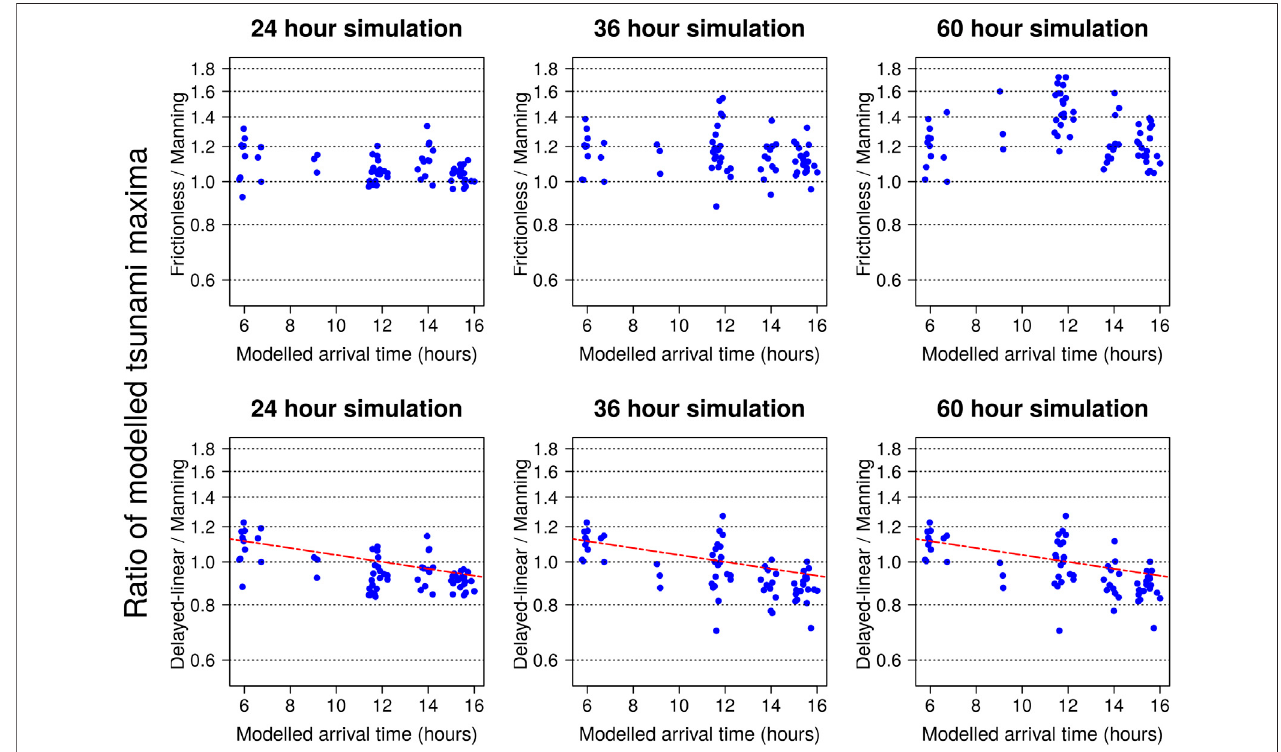
FIGURE13| Ratiosofmodeledtsunamimaxima,atnearshoresiteswithtide-gaugedata,usingdifferentoffshorefrictiontreatments: Toprow frictionless/Manning; Bottom row Delayed-linear-friction/Manning-friction. In the bottom row the dashed line is y (cid:2) 1 / exp (− f ( t 12 − t a ) / 2 ) where t a is the modeled gauge-speci fi c tsunami arrivaltime and t 12 isthenumber ofseconds in12 h; thisisalinearapproximationoftheproportionatereduction inthedelayed-linear-friction tsunami maxima ifthe initial frictionless period was t a instead of t 12 (under various assumptions appropriate for our sites, as discussed in the text).